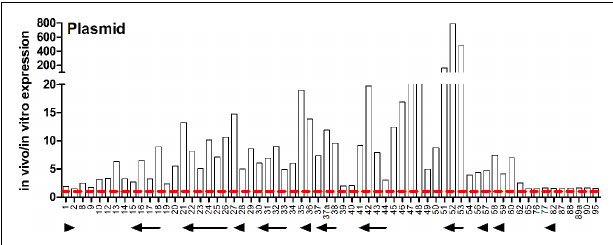
FIGURE 4 | In vivo expression of plasmid-encoded genes. Expression ratio of RNA recovered from rat lungs ( in vivo ) relative to RNA isolated from in vitro grown cultures as determined by microarray analysis.The “pBCA” designation has been removed from names of plasmid-encoded genes for image clarity. Putative operons are indicated by